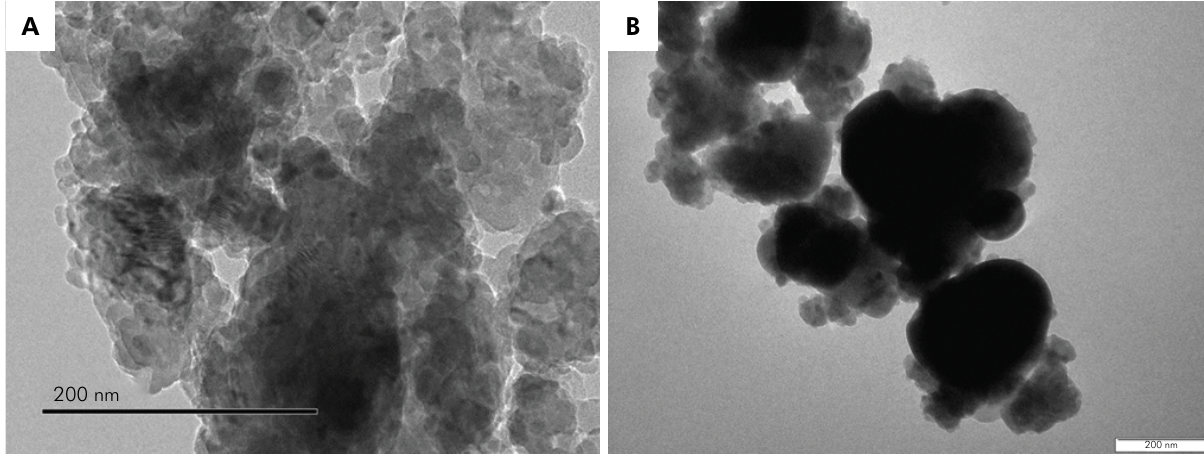
Figure 2. TEM images: (A) eggshell powder; (B) EB@TiO